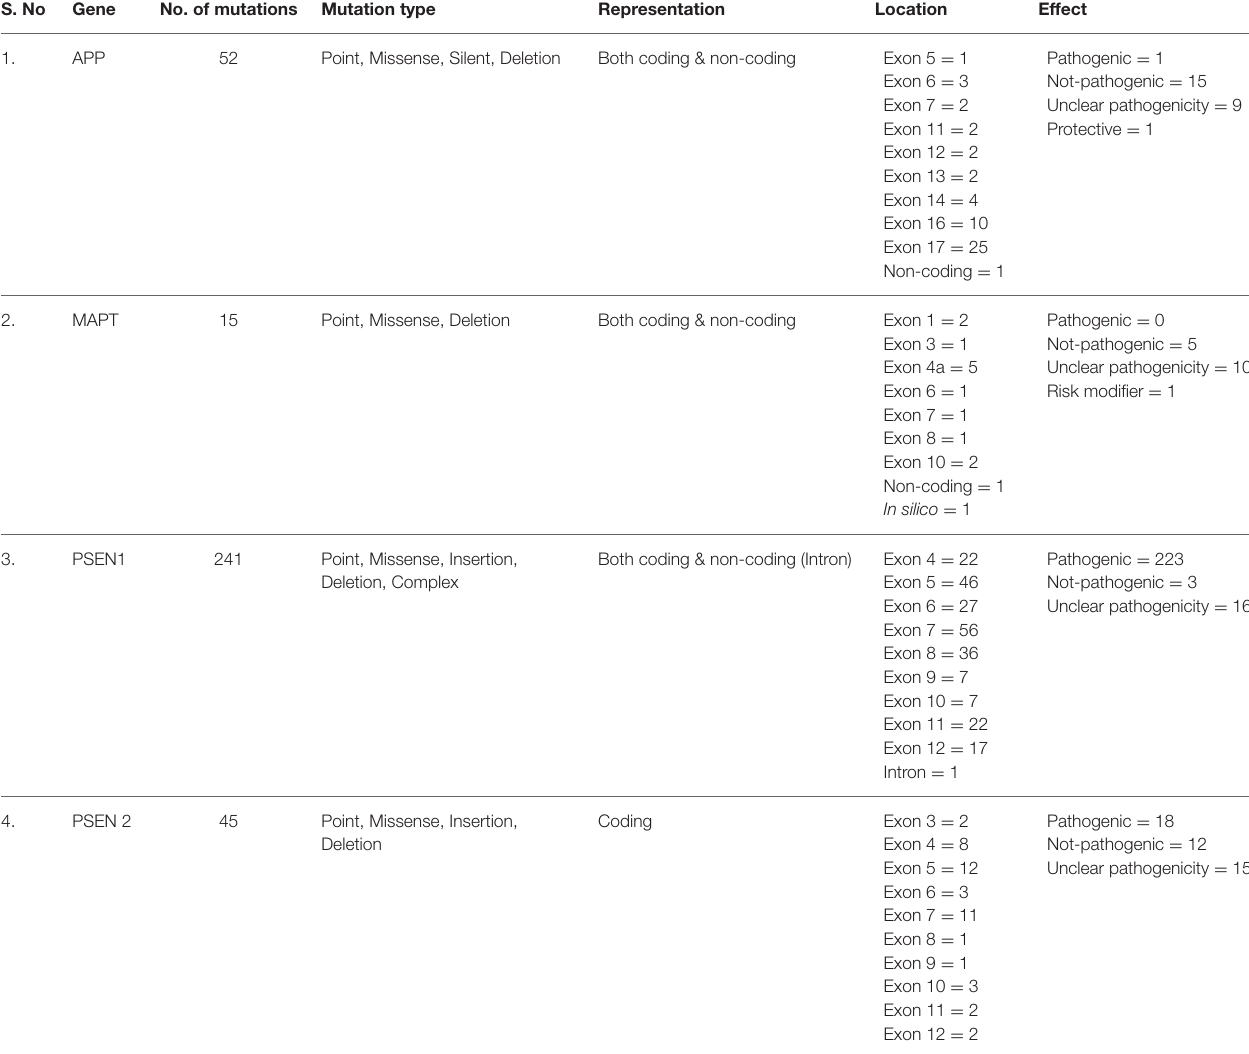
TABLE 1 | Summary of mutations predicted in genes that have been associated with the occurrence of AD. S. No